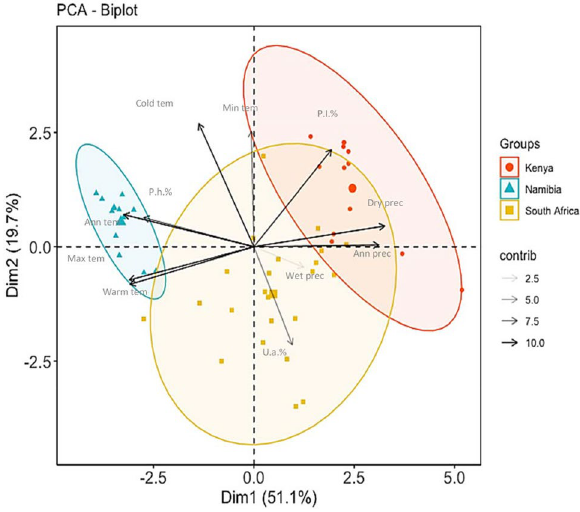
Figure 4. Principal Component Analysis (PCA) ordination of sampling sites in three Sub-Saharan countries based on the relative abundance of the dominant parasitoid species ( P. lounsburyi , P. humilis and U. africanus ). The biplot shows the relationships between bioclimatic variables and dominance of parasitoid species in each region. Climatic predictors are: Ann tem annual mean temperature, Max tem maximum temperature of the warmest month, Min tem minimum temperature of the coldest month, Warm tem mean temperature of the warmest quarter, Cold tem mean temperature of the coldest quarter, Ann prec annual precipitation, Wet prec precipitation of the wettest quarter, Dry prec precipitation of the driest quarter, and the relative proportion of P. lounsburyi (P.l.%), P. humilis (P.h.%) and U. africanus (U.t.%) to emerge from parasitized fruits. PCA statistics and graphs were performed using JMP Pro ver13 (SAS, Cary,